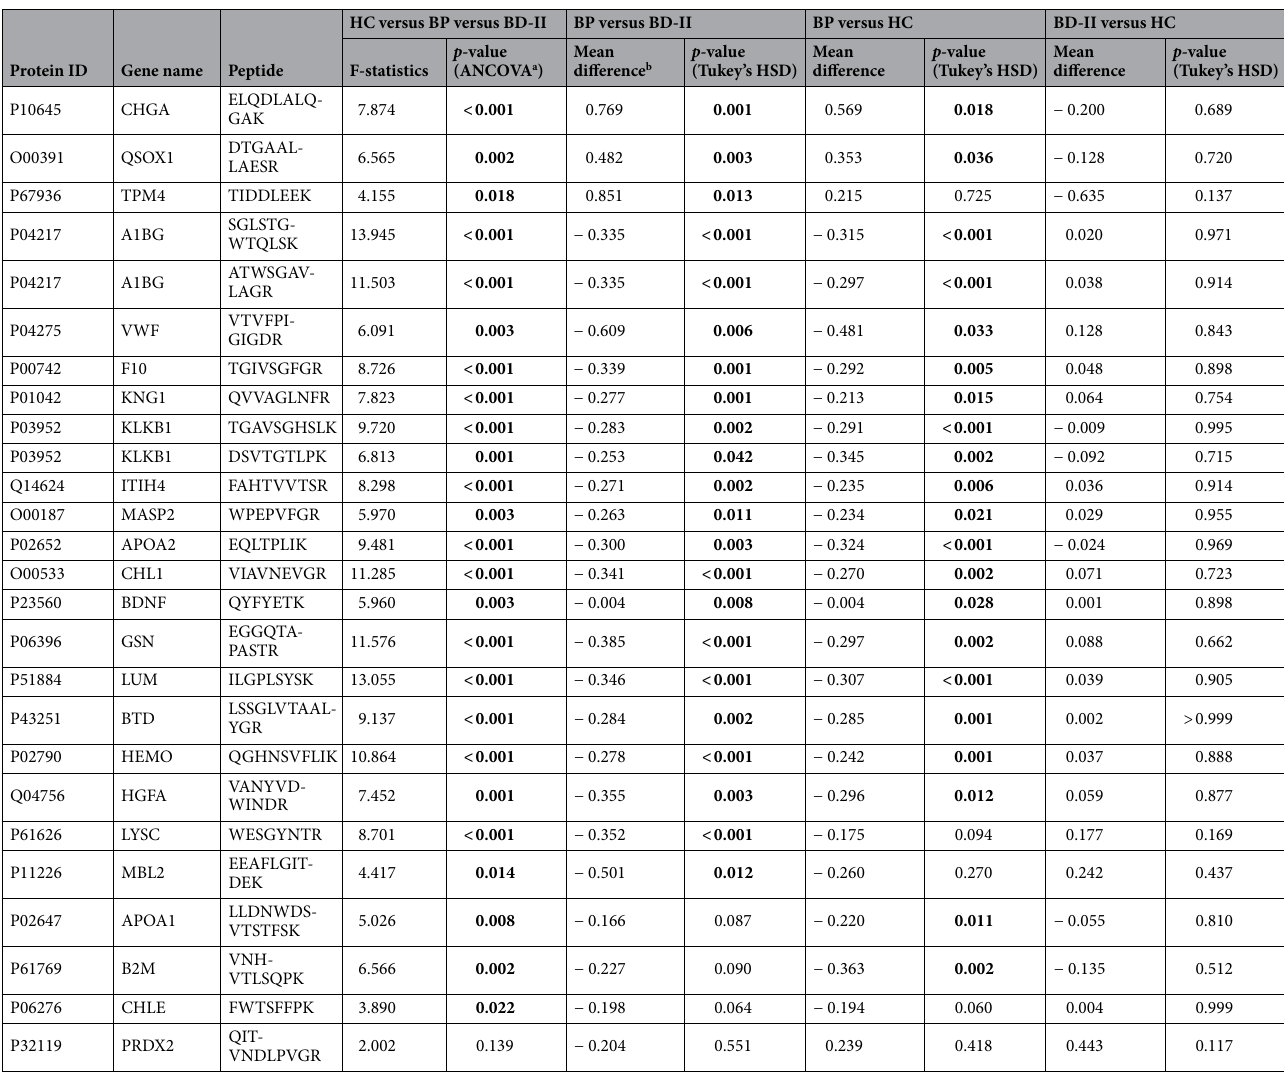
Table 2. Differentially expressed peptides identified by LC-MRM analysis between HC, BP, and BD-II. Statistically significant differences were anlyzed by ANCOVA. Multiple comparison was performed by Tukey’s HSD. Boldface p -values are significant p -value (< 0.05). a Covariates : Age, sex, use of antipsychotics, mood stabilizers, antidepressants, and benzodiazepines. b Adjusted mean difference. HC healthy control, BP bipolar II prodrome, BD-II Bipolar II disorder, ANCOVA analysis of covariance; HSD, honestly significant